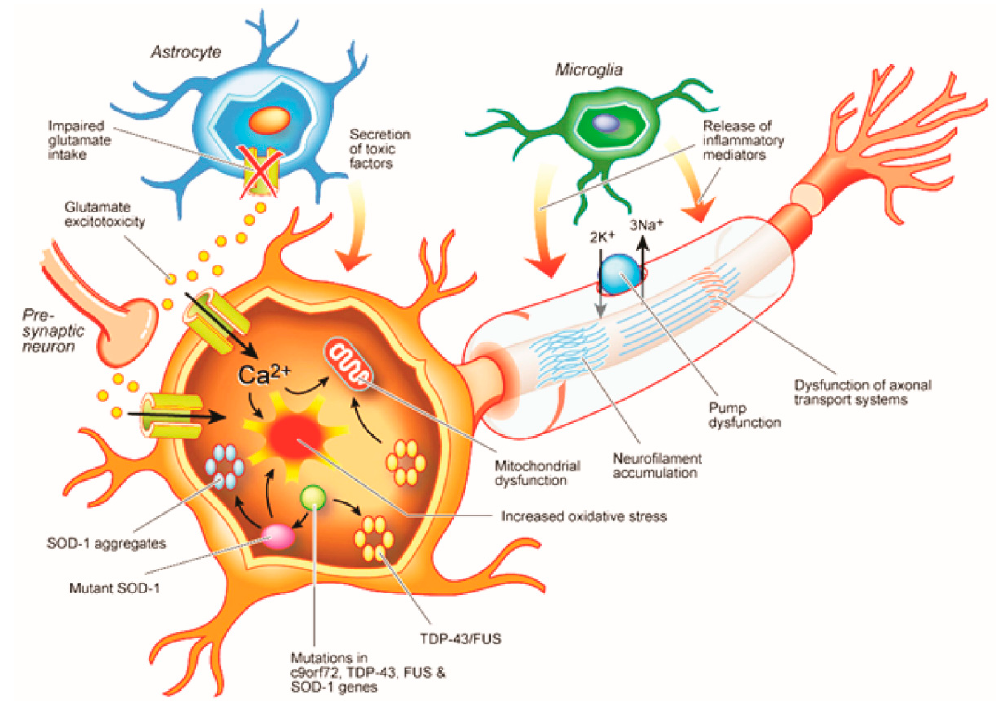
Figure 2. Amyotrophic lateral sclerosis (ALS) appears to be mediated by a complex interaction between molecular and genetic pathways. Reduced uptake of glutamate from the synaptic cleft, leading to glutamate excitotoxicity, is mediated by dysfunction of the astrocytic excitatory amino acid transporter 2 (EAAT2). The resulting glutamate-induced excitotoxicity induces neurodegeneration through activation of Ca 2 + -dependent enzymatic pathways. Mutations in the c9orf72, TDP-43 and fused in sarcoma (FUS) genes result in dysregulated RNA metabolism leading to abnormalities of translation and formation of intracellular neuronal aggregates. Mutations in the superoxide dismuates-1 (SOD-1) gene increases oxidative stress, induces mitochondrial dysfunction, leads to intracellular aggregates, and defective axonal transportation. Separately, microglia activation results in secretion of proinflammatory cytokines and neurotoxicity.